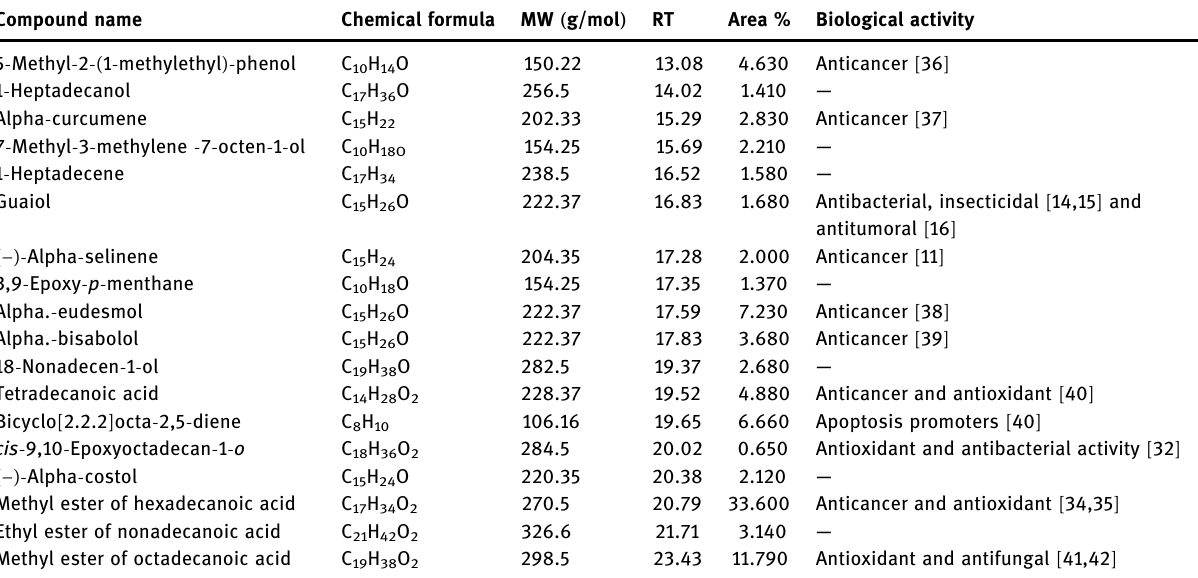
Table 2: Compounds identi fi ed in the hexane extract of propolis by GC - MS Compound